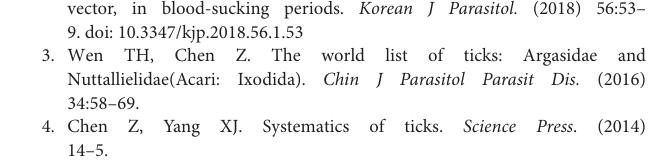
Supplementary Figure S1 | Length distribution of unigenes. Supplementary Figure S2 | Gene annotation results of seven databases. Supplementary Figure S3 | Gene Ontology (GO) annotation of H. longicornis ovary genes. Supplementary Figure S4 | The euKaryotic Ortholog Group (KOG) annotation of H. longicornis ovary genes. Supplementary Figure S5 | Kyoto Encyclopedia of Genes and Genomes (KEGG) annotation of H. longicornis ovary genes. Supplementary Figure S6 | Correlation analysis of mass spectrometry data in ovaries of the two reproductive groups of H. longicornis . Supplementary Figure S7 | Gene Ontology (GO) annotation of H. longicornis ovary proteins. Supplementary Figure S8 | The euKaryotic Ortholog Group (KOG) annotation of H. longicornis ovary proteins. Supplementary Figure S9 | Kyoto Encyclopedia of Genes and Genomes (KEGG) annotation of H. longicornis ovary proteins. Supplementary Table S1 | Primer information of quantitative PCR genes. Supplementary Table S2 | Data acquisition and assembly results of the transcriptome data and